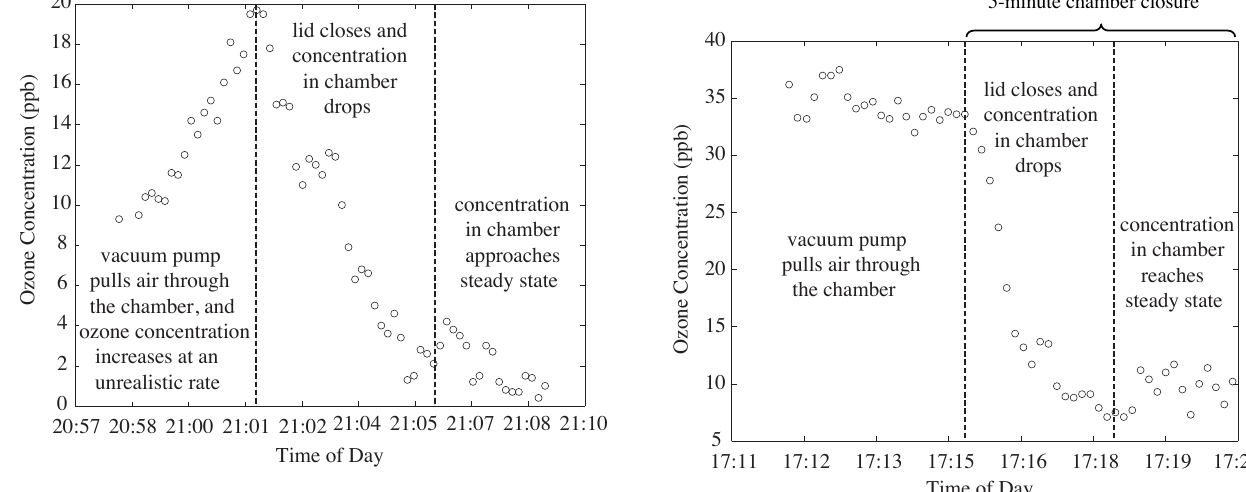
Figure 3. The plot above is an example of a run where the data could not be used to calculate a flux. The ozone concentration increases by an unreasonable amount when the chamber lid opens, which likely indicated malfunction in the 2B ozone monitor.